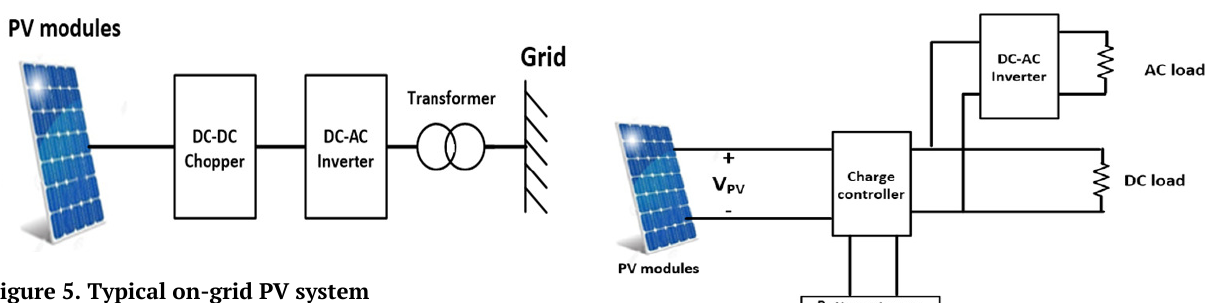
Figure 5. Typical on-grid PV system